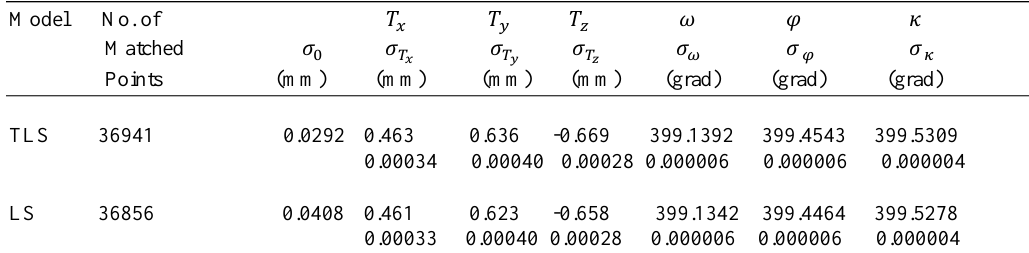
Table 1. Numerical results of „Weary Heracles‟